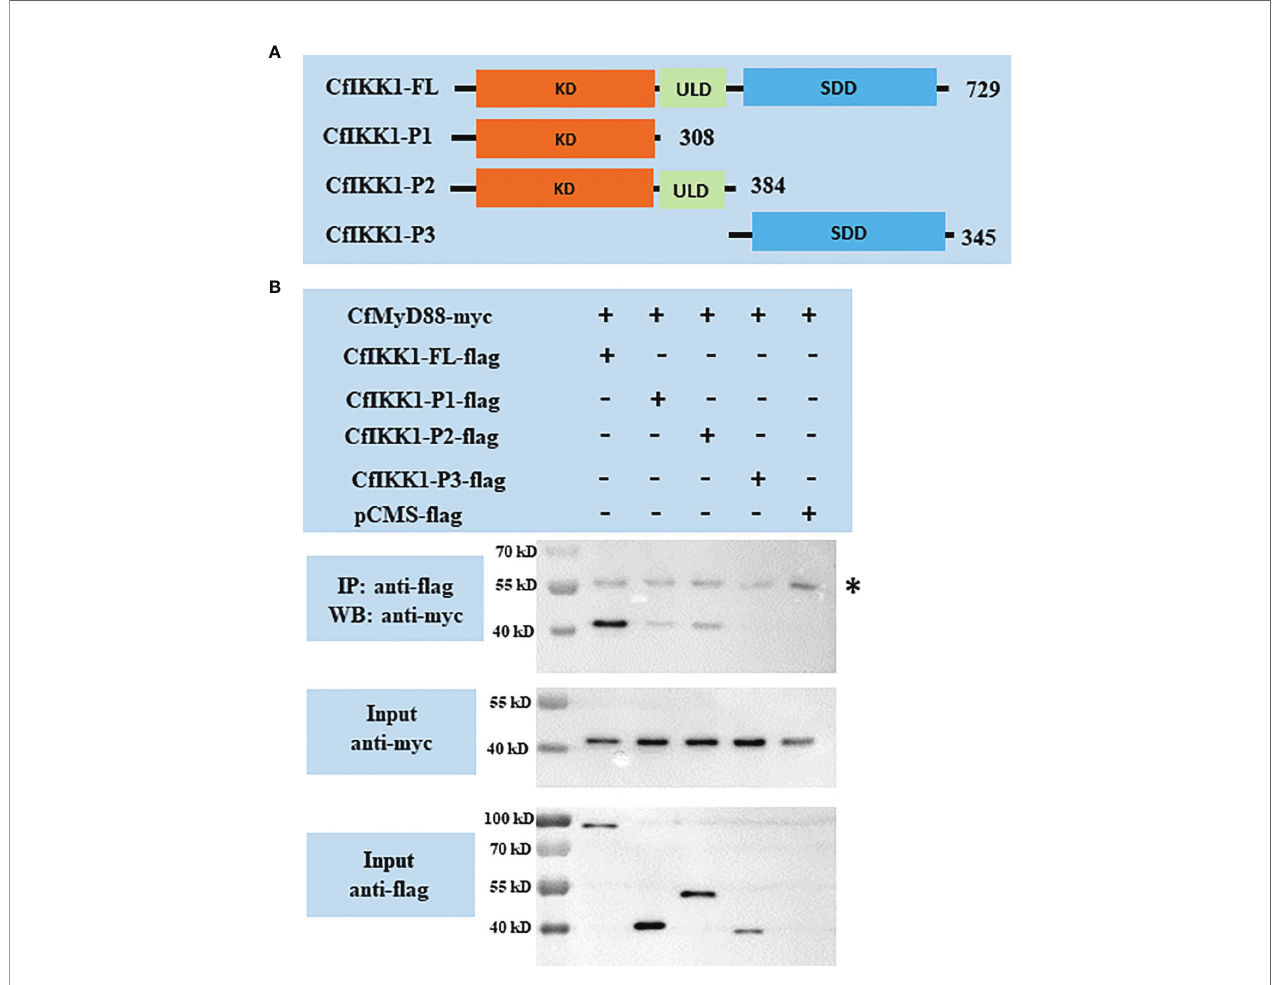
FIGURE 5 | (A) Schematic representations of the wild-type full-length CfIKK1 protein (CfIKK1-FL) and truncated mutant CfIKK1-P1, CfIKK1-P2, and CfIKK1-P3 proteins. The protein lengths and domains are annotated. (B) Interaction between CfIKK1 and CfMyD88, as veri fi ed using co-immunoprecipitation (co-IP) assays. The co-IP of CfMyD88 proteins with various CfIKK1- fl ag proteins (CfIKK1-FL, CfIKK1-P1, CfIKK1-P2, and CfIKK1-P3) was facilitated using anti- fl ag M2 magnetic beads and analyzed by western blot assay using the anti-myc antibody (top). Input samples were detected using anti-myc (middle) and anti- fl ag antibodies (bottom), respectively, to con fi rm the myc- and fl ag-fused protein expression. CfMyD88-myc could be detected in the anti- fl ag immunoprecipitates of co-transfected (CfIKK1- FL, CfIKK1-P1, and CfIKK1-P2) cell extracts, indicating the interaction of CfMyD88-myc with CfIKK1-FL- fl ag, CfIKK1-P1- fl ag, and CfIKK1-P2- fl ag. Asterisk represents the heavy chain of mouse IgG. KD, kinase domain; SDD, scaffold dimerization domain; IP, co-immunoprecipitation assay; WB, western blot